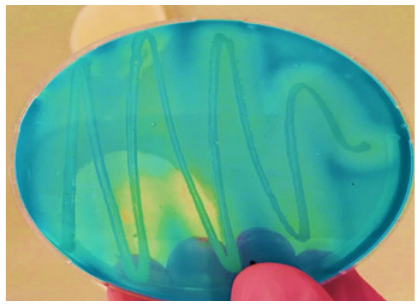
Fig. 6. DNase positive result for Staph.aureus isolated